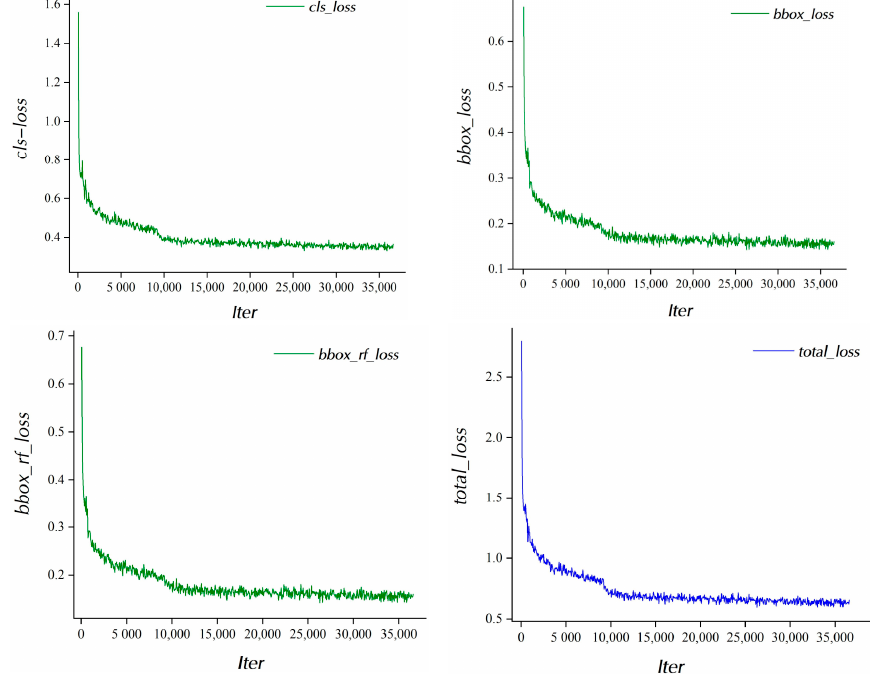
Figure 9. Loss curve of sea-surface obstacle dataset.